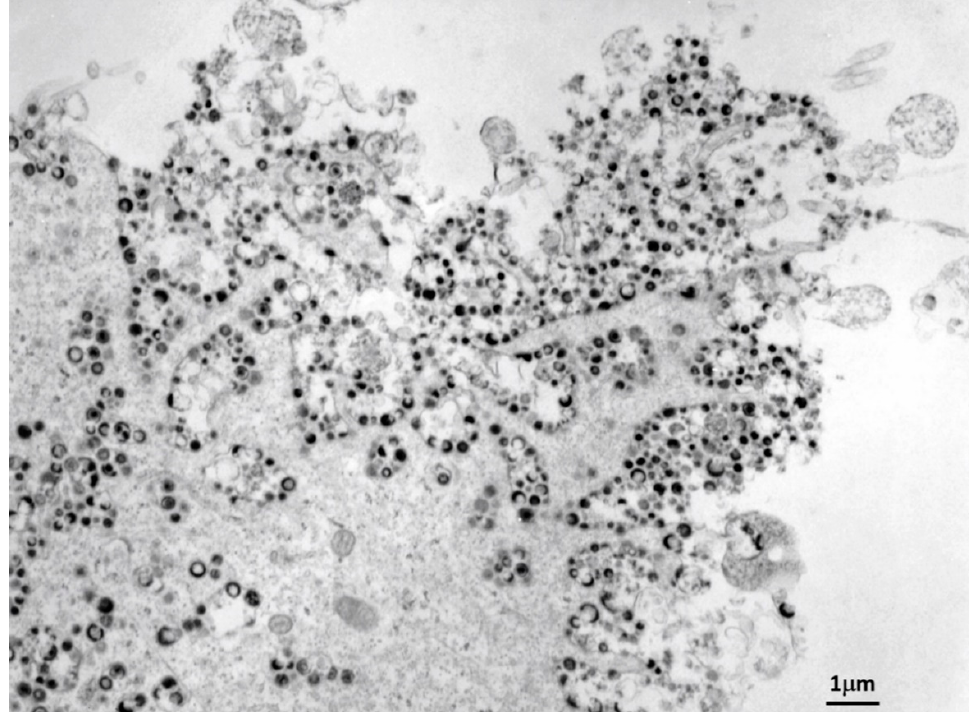
Figure 1. Electron micrograph of cells infected with the varicella vaccine virus. Hundreds of viral particles are easily detected in fibroblast cells infected with the vaccine strain Oka. These infected cells are harvested under non-denaturing conditions in order to produce the live varicella vaccine product. Each vial of varicella vaccine contains 1350 plaque-forming units of infectious viral particles similar in appearance to those seen in this figure.